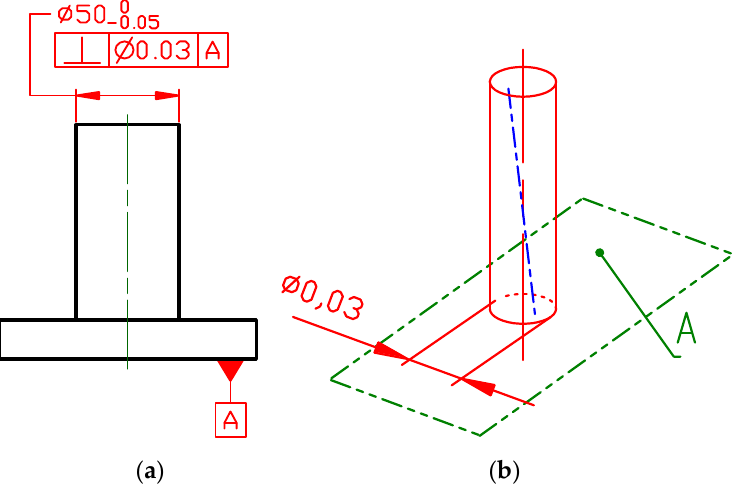
Figure 9. ( a ) Specification of perpendicularity tolerance for the pin with respect to the bottom of its flange (ASME Y14.5); ( b ) minimum circumscribed cylinder axis within the cylindrical tolerance zone.